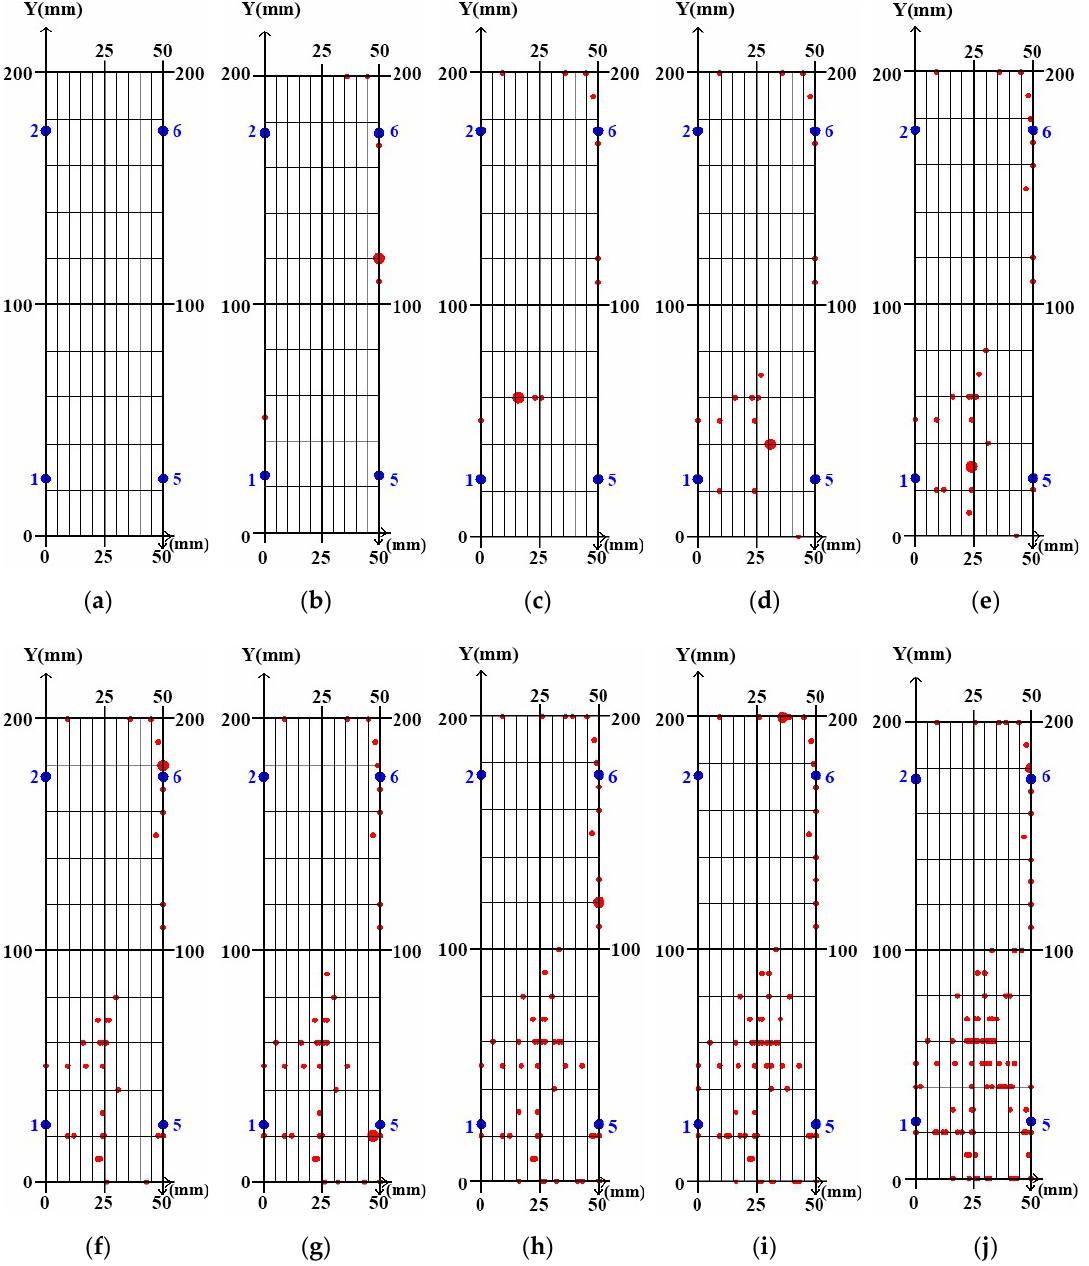
Figure 6. Distribution of AE events for serial coal pillar specimens with different strength. ( a ) 0 s; ( b ) 600 s; ( c ) 900 s; ( d ) 1200 s; ( e ) 1500 s; ( f ) 1800 s; ( g ) 1900 s; ( h ) 2000 s; ( i ) 2100 s; ( j ) 2162 s. Note: The denoted letters shown in the figure was corresponding to those on the stress-time curve in Figure 5.